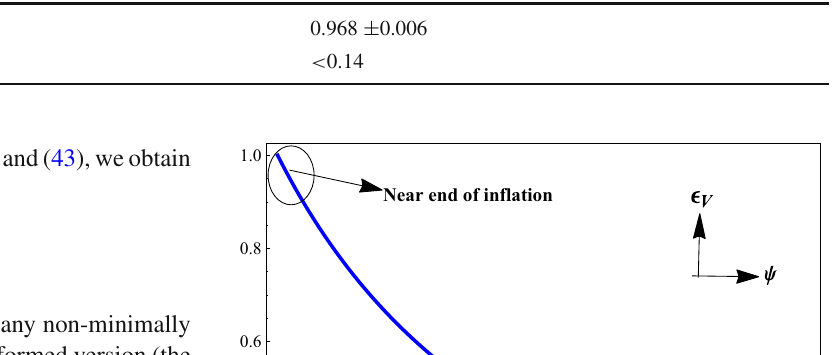
Table 1 Theoretical and observational results of n s and r Parameters ( n s and r ) Theoretical results from the present model (for N ∗ = 60) Observational results from PlanckTT + lowP + lensing 2015 n s 0.963 0.132 < 0.14